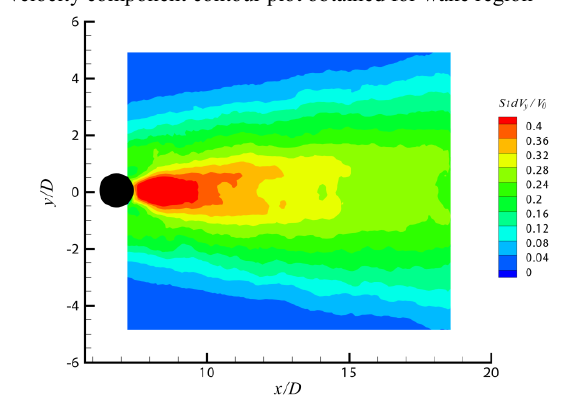
Fig. 13. Normalized mean standard deviation of streamwise velocity component contour plot obtained for wake region